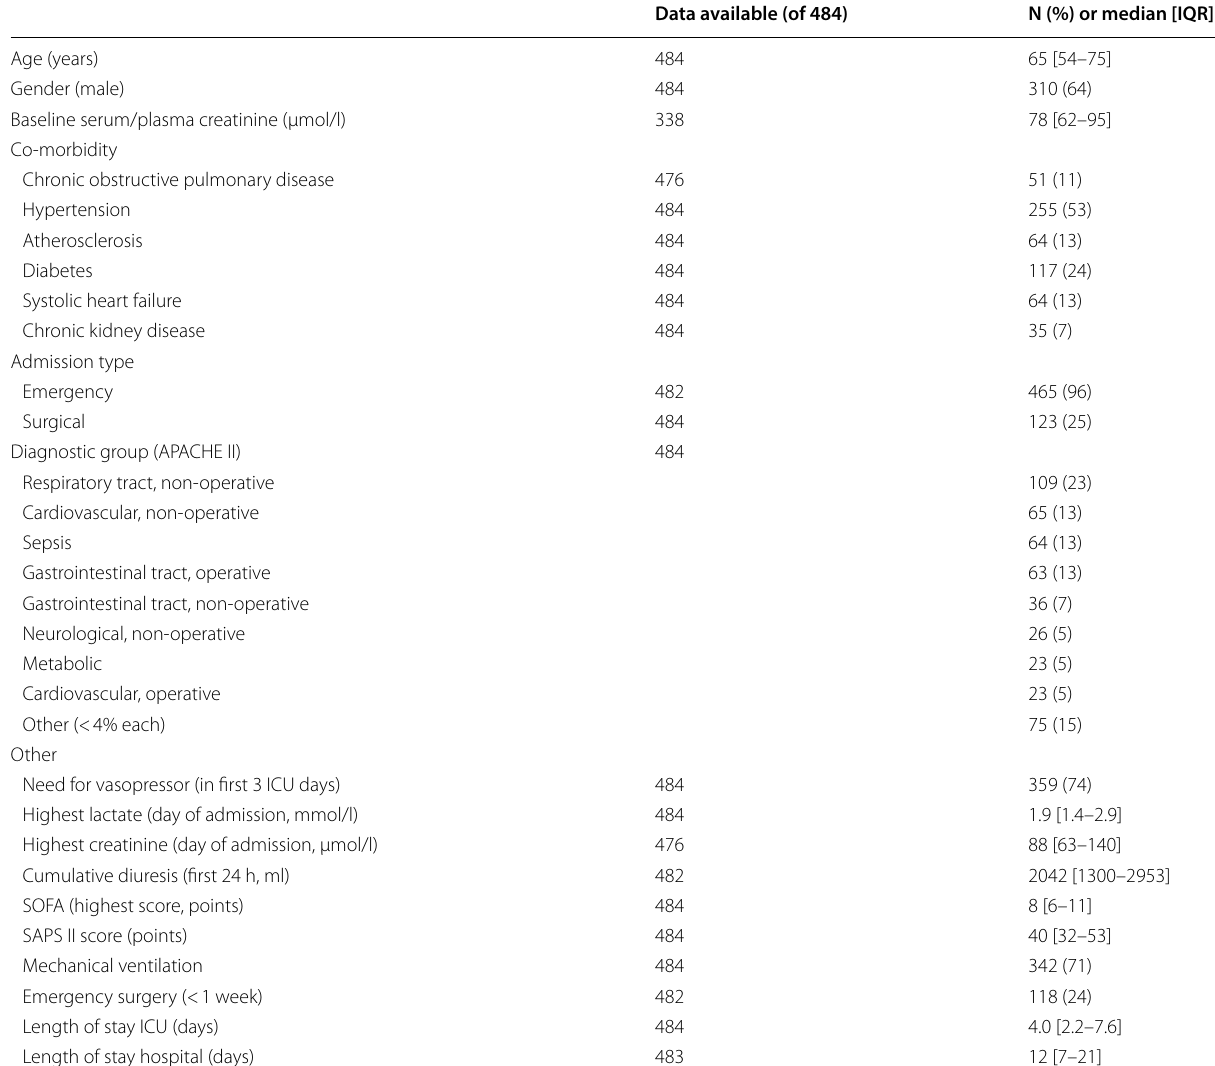
Table 1 Characteristics of 484 critically ill sepsis